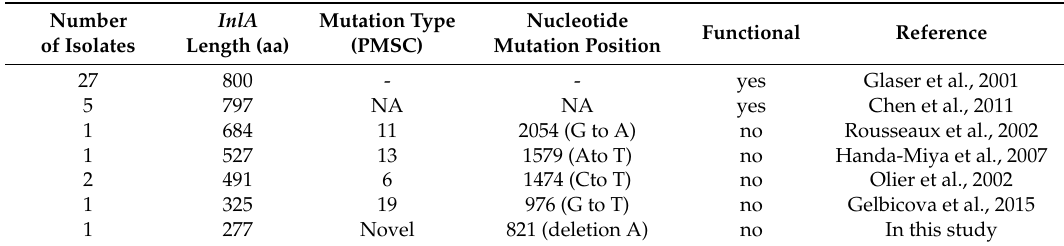
Table 2. Length of Inl A among Chilean L. monocytogenes.